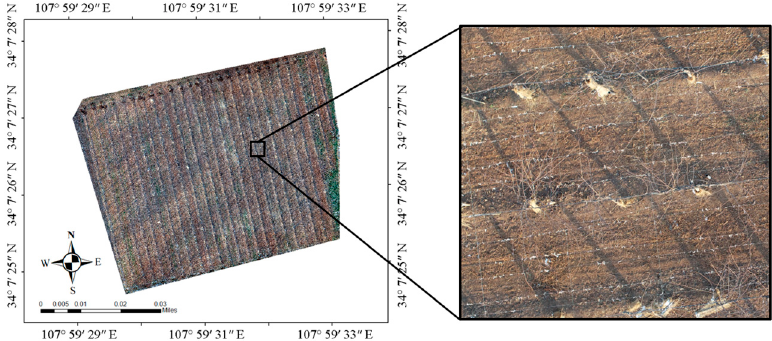
Figure 1. Remote sensing image of the experimental land and field enlarged picture.